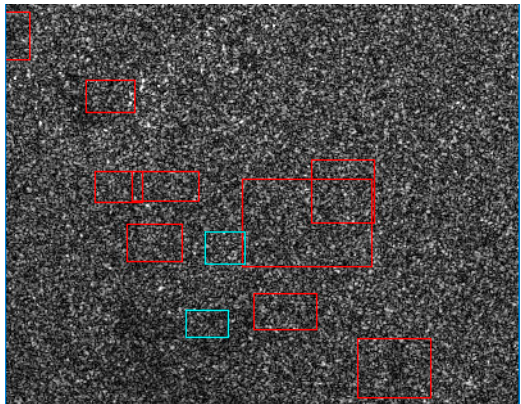
Figure 8. Several clusters of Saka kurgans in TSX SL image acquired on 14 July 2015 (SAR images © DLR, 2015). ( Saka kurgans = red, Scythian kurgans = green rectangle, ogradkas = purple, undatable mounds = yellow, and all other objects = cyan).